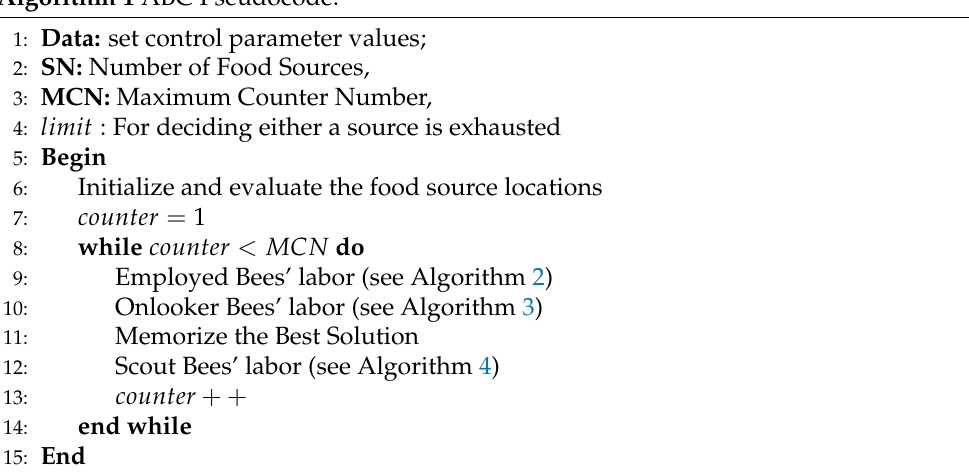
Algorithm 1 ABC Pseudocode.